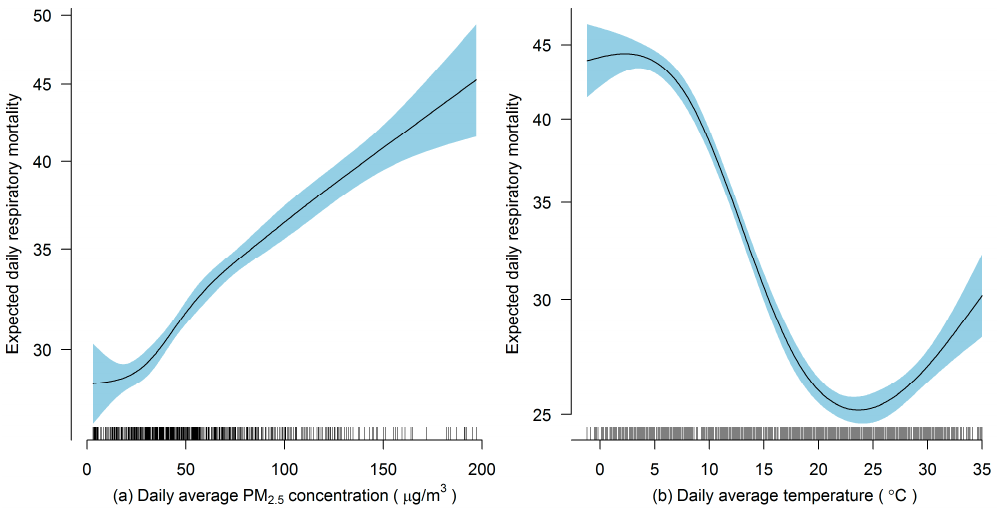
Figure 2. Smoothing plots of ( a ) daily respiratory mortality against daily average PM 2.5 concentration and ( b ) daily average temperature.